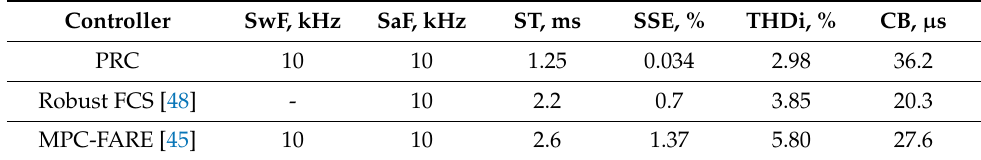
Table 1. Comparison information between